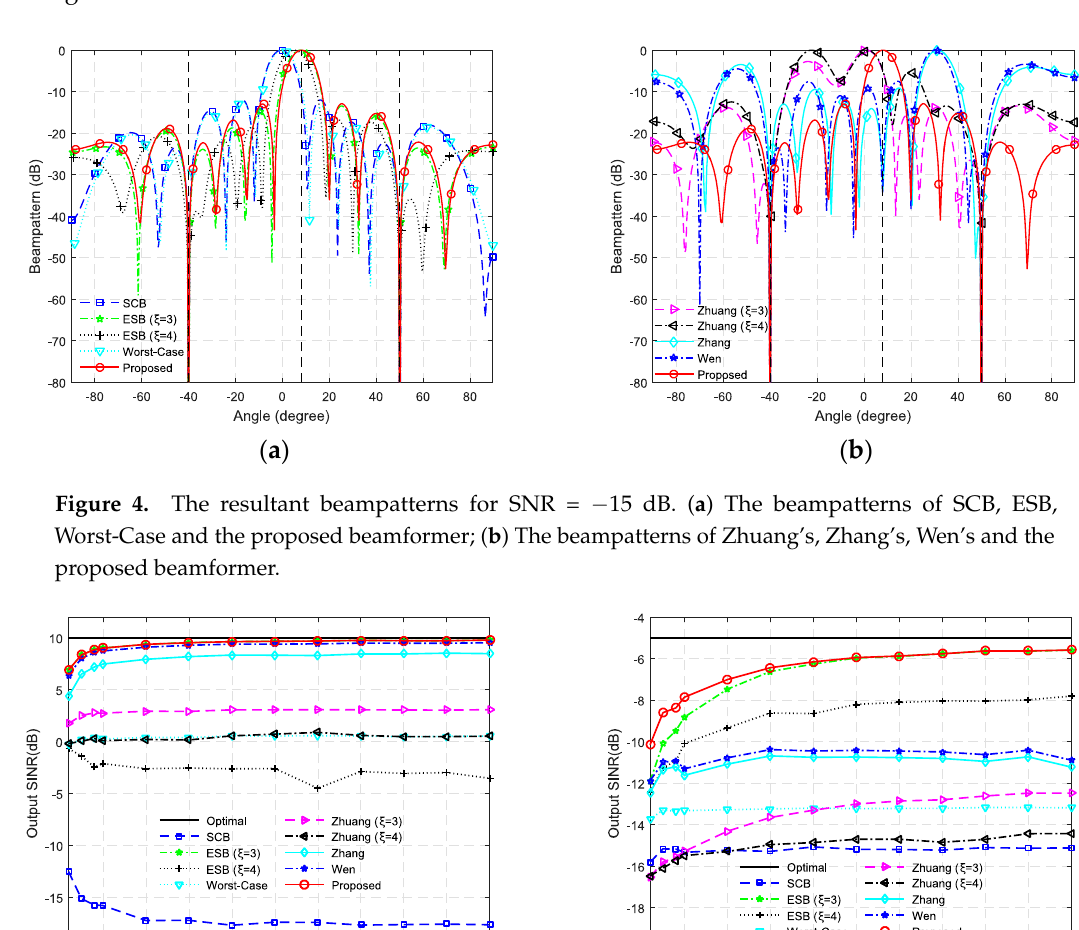
Figure 3. The resultant beampatterns for SNR = 0 dB. ( a ) The beampatterns of SCB, ESB, Worst-Case and the proposed beamformer; ( b ) The beampatterns of Zhuang’s, Zhang’s, Wen’s and the proposed beamformer. Figure 4. The resultant beampatterns for SNR = − 15 dB. ( a ) The beampatterns of SCB, ESB, Worst-Case and the proposed beamformer; ( b ) The beampatterns of Zhuang’s, Zhang’s, Wen’s and the proposed beamformer.